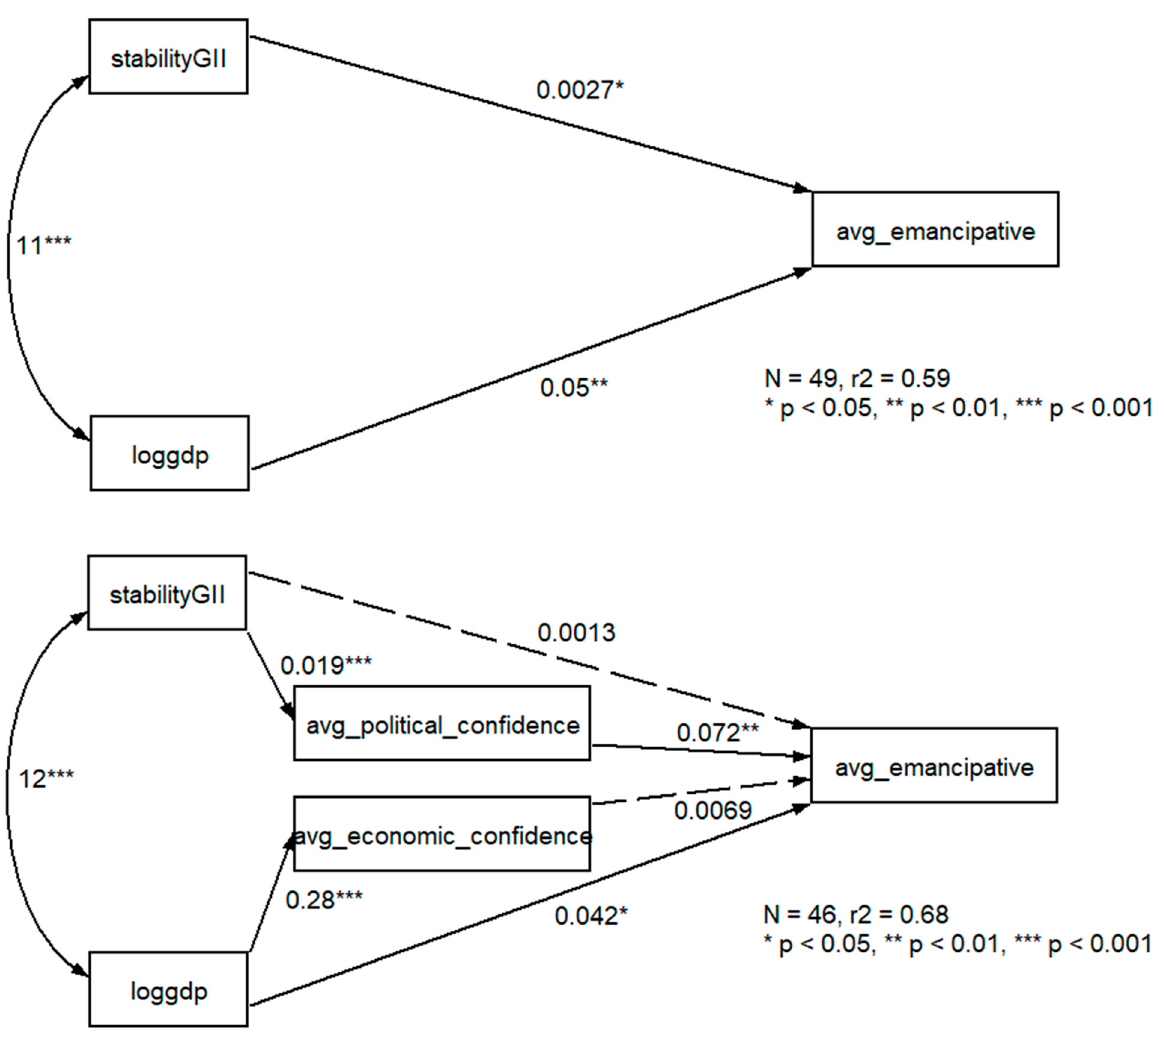
Figure 2. SEMs for emancipative values. Note : Solid lines are used to denote significant paths.